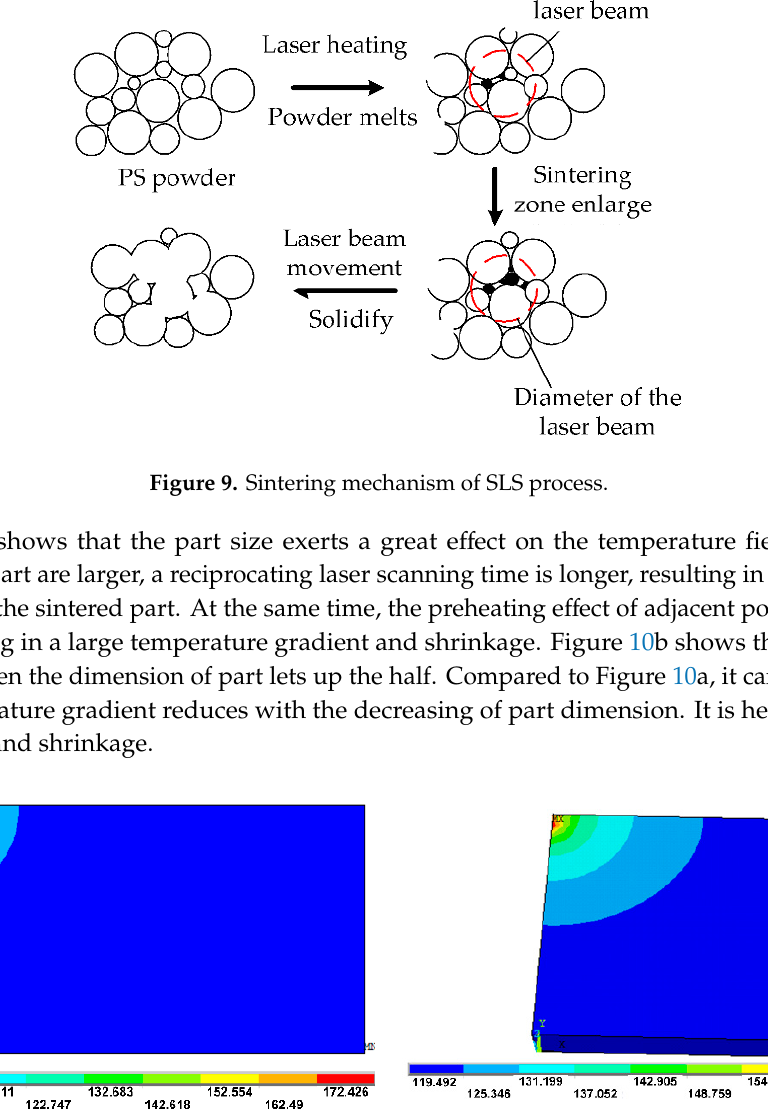
Figure 8. Temperature time history of identification of points.